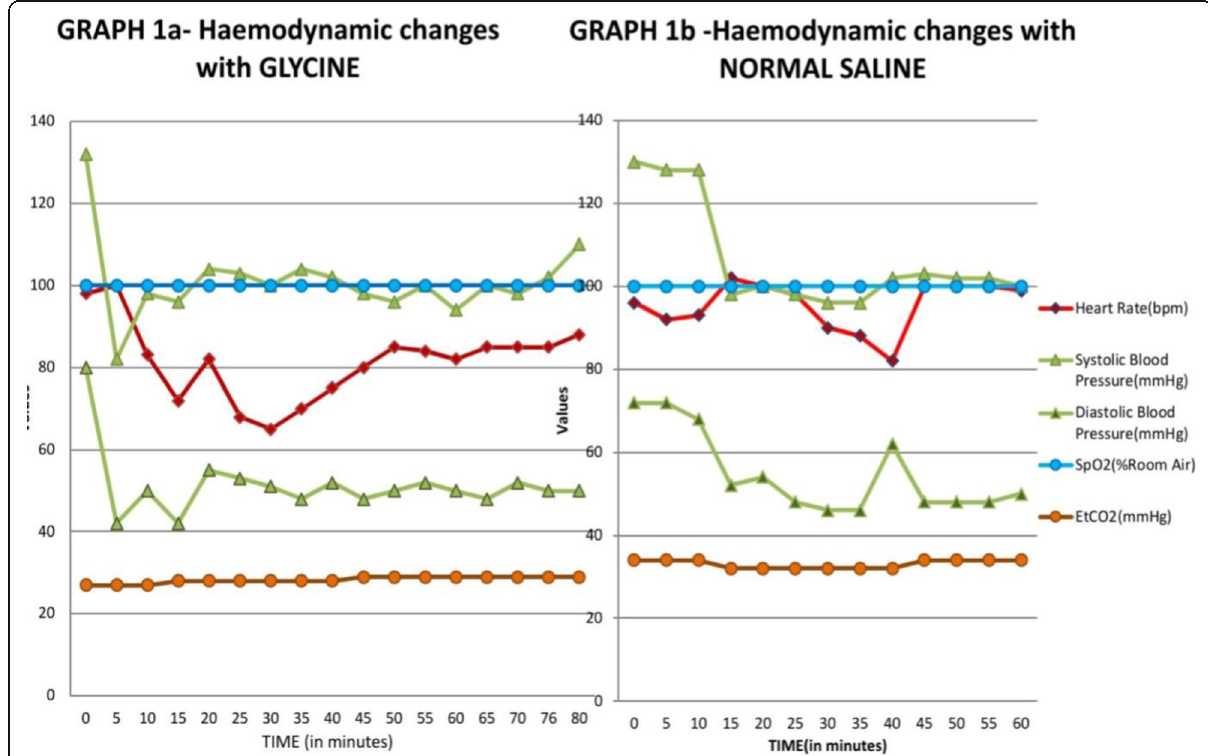
Fig. 1 Hemodynamic changes in phase 1 (glycine) and phase 2 (normal saline) of